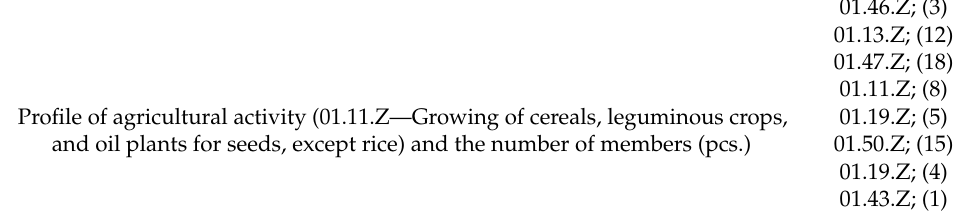
Profile of agricultural activity (01.11.Z—Growing of cereals, leguminous crops, and oil plants for seeds, except rice) and the number of members